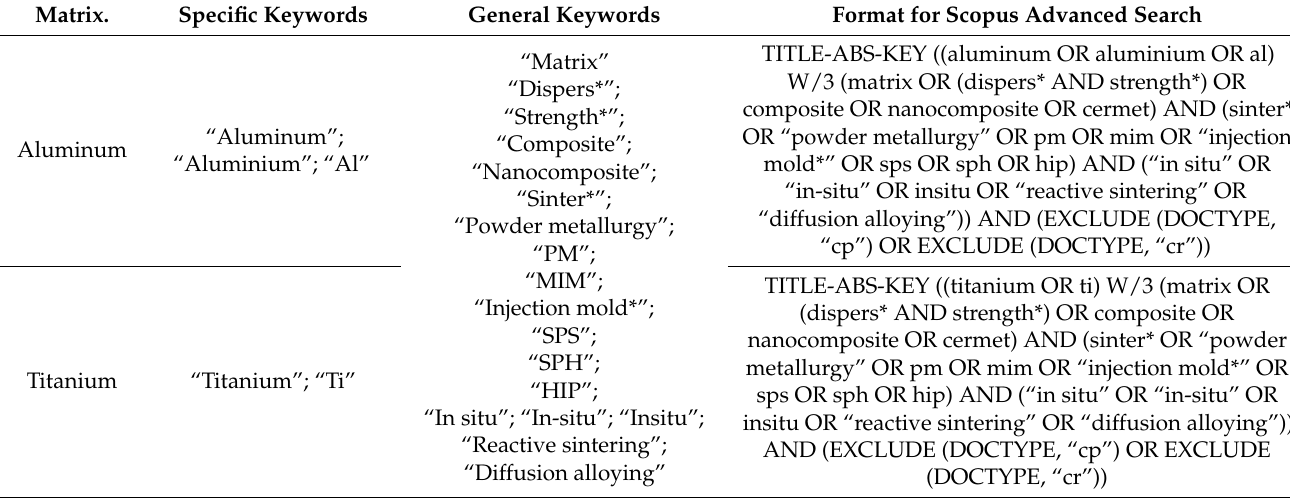
Table A1. Scopus database search